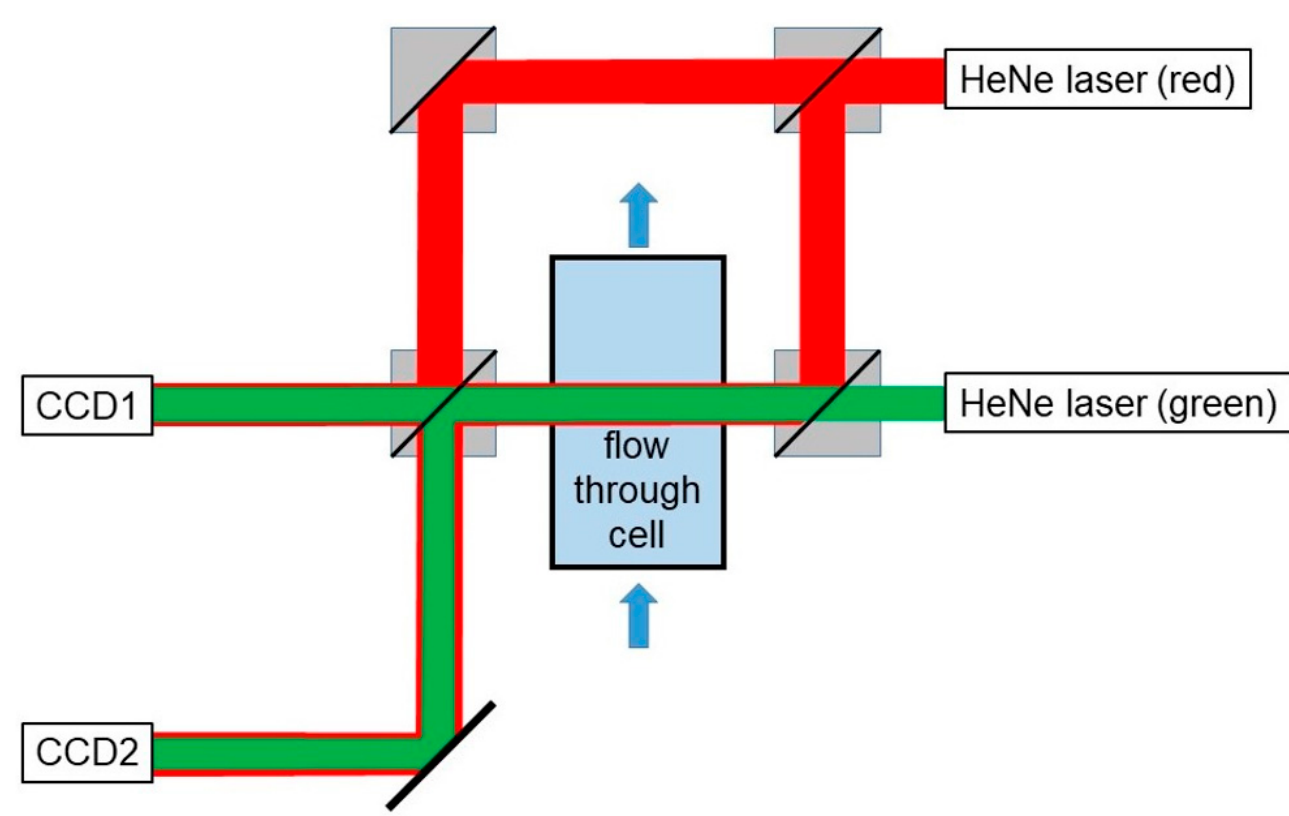
Figure 1. Experimental set-up showing the Mach–Zehnder interferometer with the integrated flow- through cell.